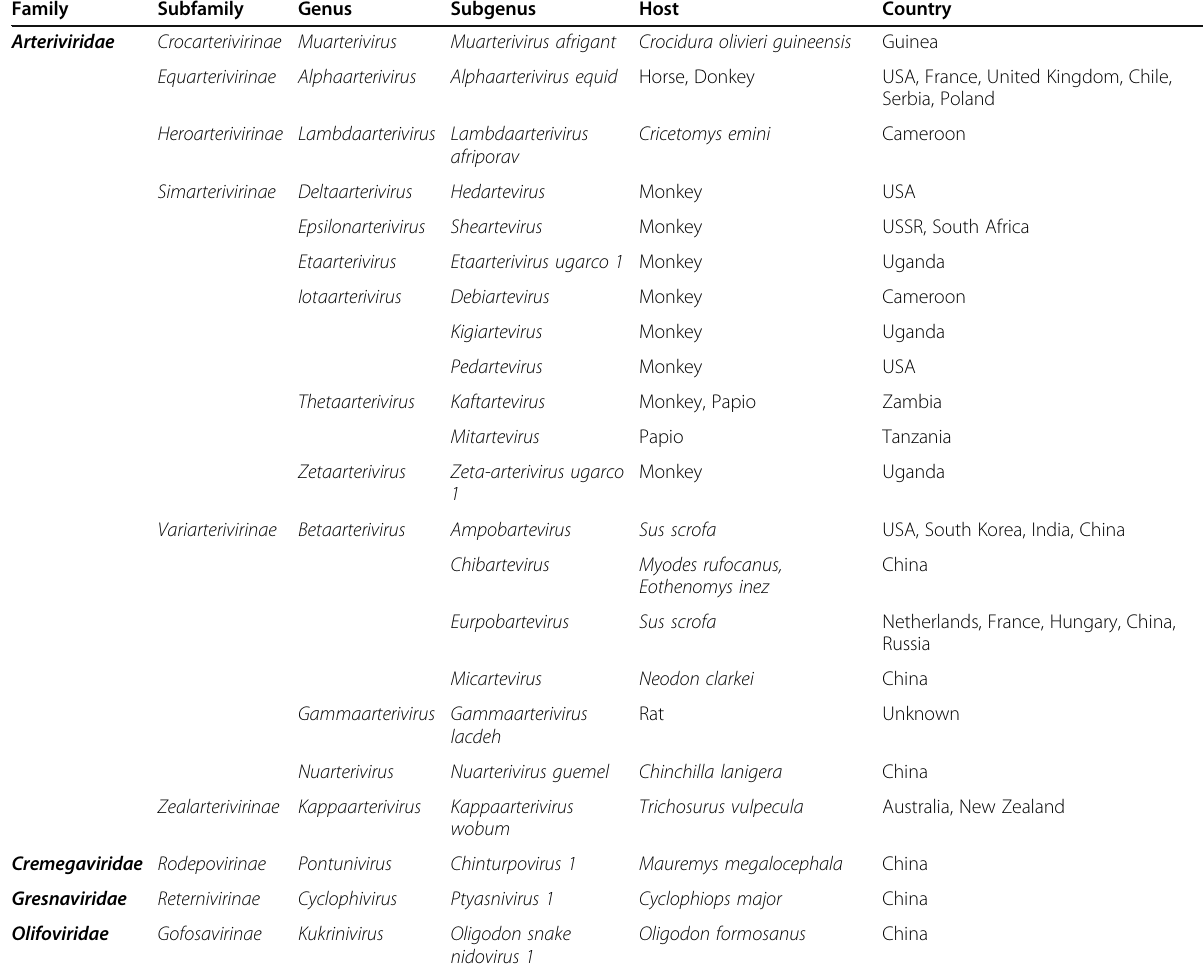
Table 2 Hosts and sampled countries of Arnidovirineae viruses